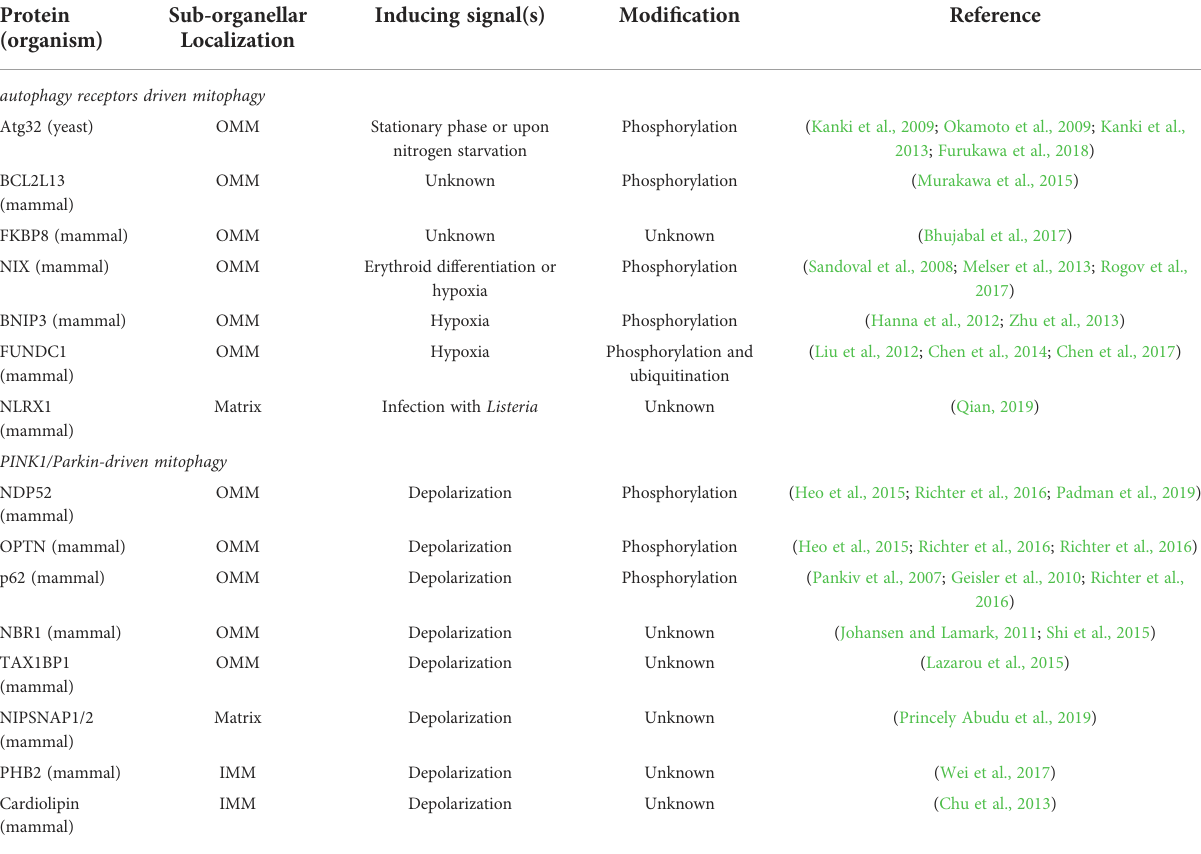
TABLE 1 Autophagy receptors/adaptors that regulate